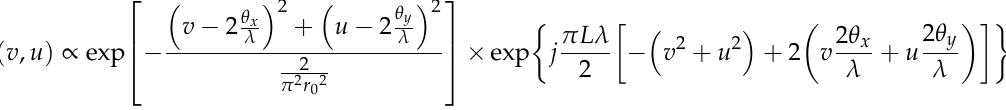
Figure 24. Schematic diagram of the laser frequency-shifted feedback imaging system. ML, microchip laser; L1, collimator; BS, beam splitter; AOM1 and AOM2, acousto-optic modulators; L2, optical lens; Mr, reference mirror; AP, aperture; BE, beam expander; GM1 and GM2, galvanometric mirrors; L3 and L4, lenses forming the 4f system; L5, objective lens; T, target; PD, photodetector. The inset picture illustrates the physical meaning of the misalignment parameters θ x and θ y , where the dashed red line implies an ideal direction of the laser when θ x = θ y = 0. (Figure reproduced from Ref. [96]).